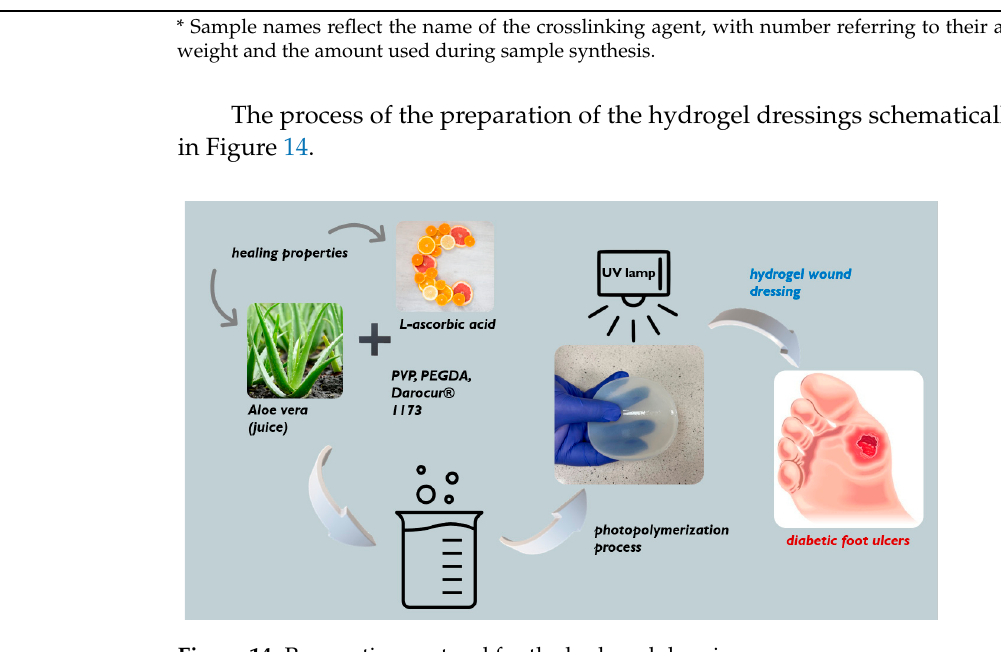
Figure 14. Preparation protocol for the hydrogel dressings.